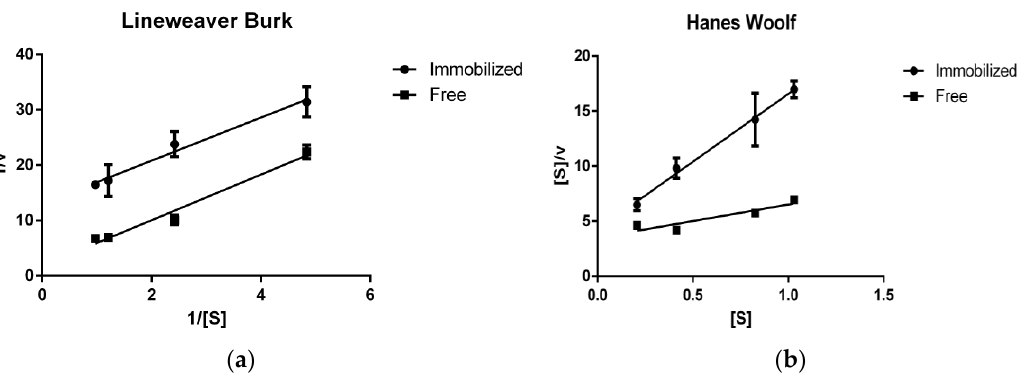
Figure 5. Lineweaver Burk (1/[ S ] (mL/mg) vs. 1/ v (mL × min/mg)) ( a ) and Hanes–Woolf ([ S ] (mg/mL) vs. s / v (min)) ( b ) linearized plotting techniques for the estimation of kinetic parameters of free and immobilized EndoBI-1 on RNase B.